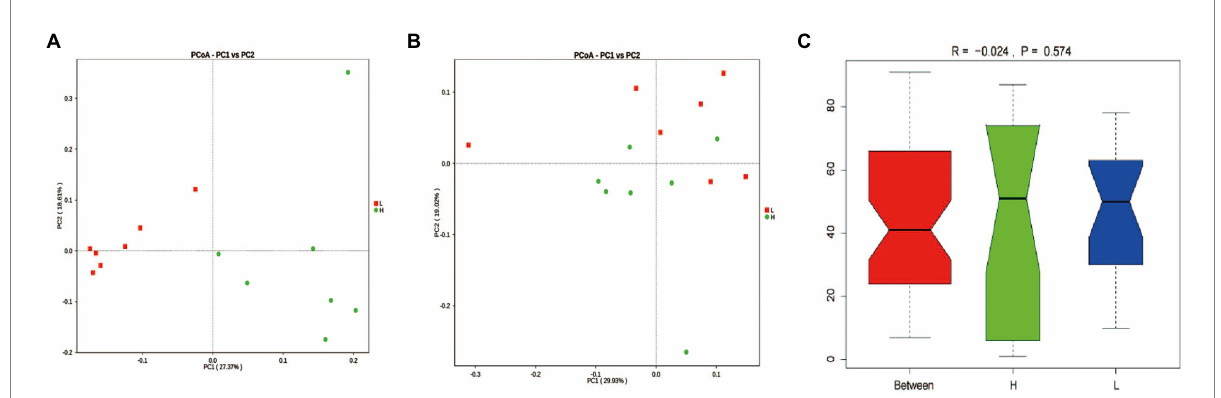
FIGURE 3 Rumen microbial OTU development. (A) Unweighted UniFrac and (B) Weighted UniFrac distances based on the relative abundance of microbial OTUs, (C) Bary-Curtis Anosim analysis. H: high MR feeding level group, fed MR at 4% DM/kg of average body weight per day; L: low MR feeding level group, fed MR at 2% DM/kg of average body weight per